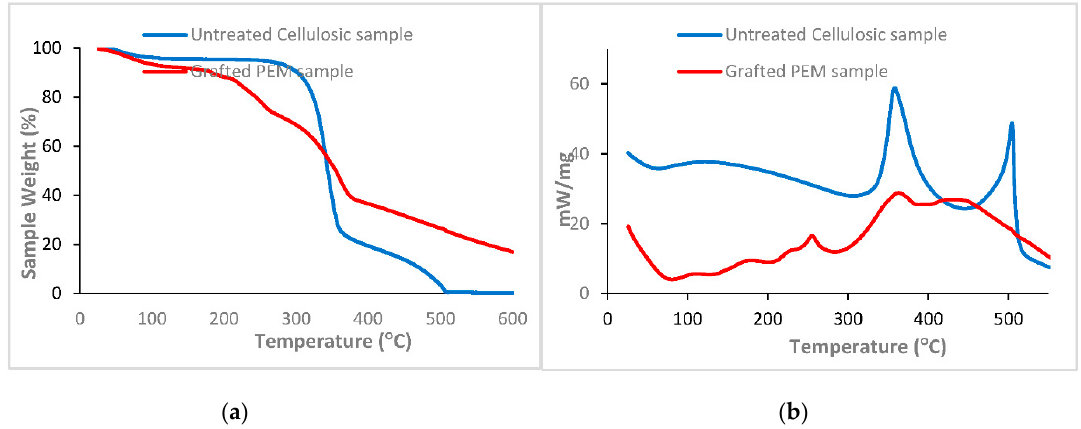
Figure 4. TGA ( a ) and DTA ( b ) thermograms of virgin cellulosic sample and grafted PEM bio-sorbent material.